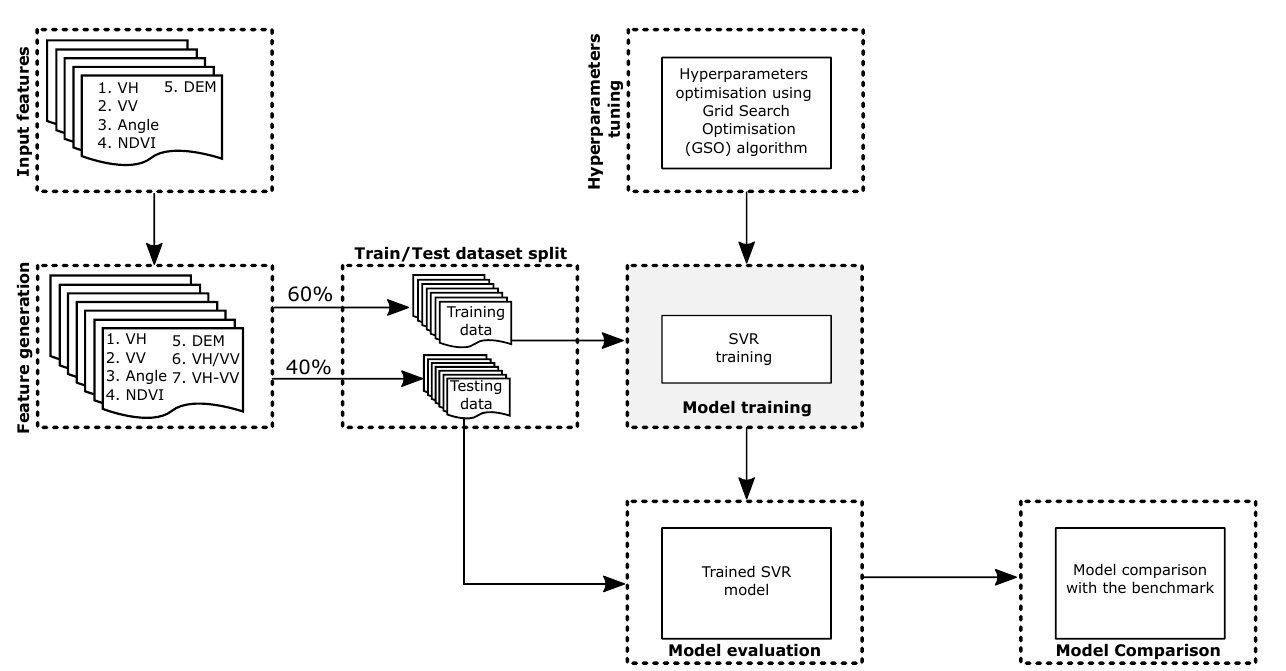
Figure 6. Flowchart illustrates the overall methodology used to set-up the SVR model. We applied the Principal Component Analysis (PCA) to select the most uncorrelated information from the feature data. We selected the first five principal components of the feature data. This explains about 99% variance and reduces the time and space complexity required for the training and evaluation of the model. We then standardised the features to find the optimal scaling methods to predict surface roughness. We applied different methods, i.e., Not Standardised (NS), Center Mean (CM), Z-score Mean (ZM), Min–Max (MM), and Scale (S), to standardise our input features. Table 2 reports the description of different standardisation methods.